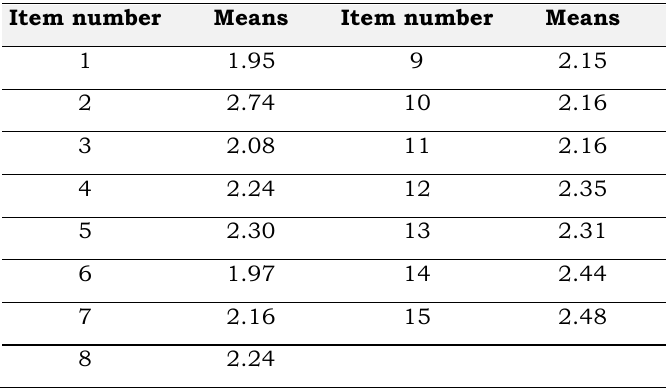
Table 2: The means of responses on CA questionnaire Item number Means Item number Means 1